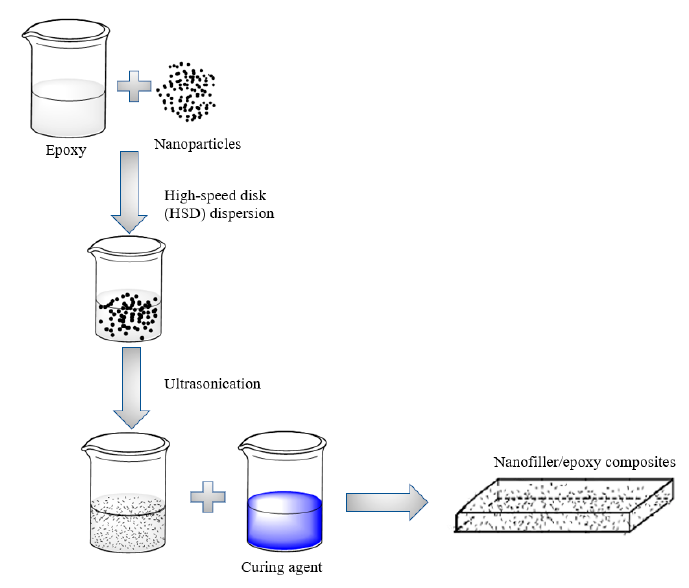
Figure 1. Schematic of the fabrication process of the nano-modified composite coating.